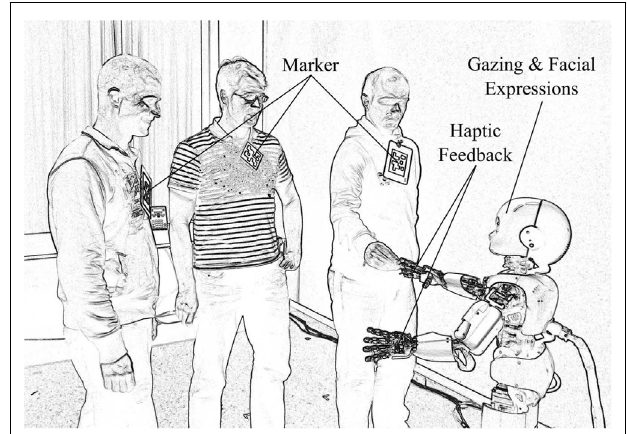
FIGURE 1 |The humanoid robot iCub in the experimental environment . The robot detects people in its field of view with the help of markers. Haptic sensing delivers rewarding or punishing signals to the learning networks. Gazing by means of head movements, speech output, and facial expressions provide feedback to the human